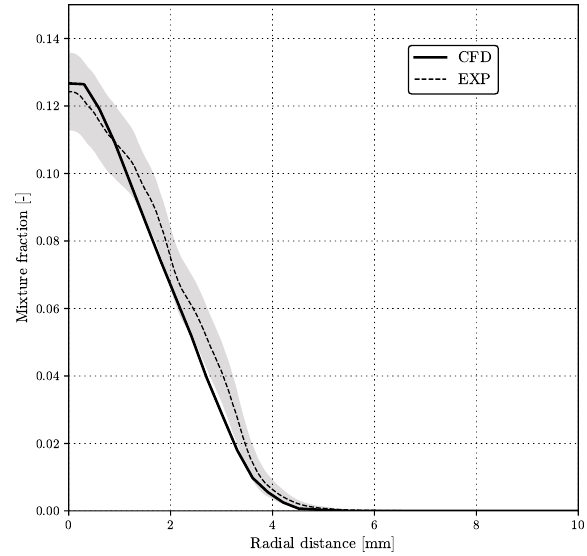
Figure 9. Radial mixture fraction distribution at z = 25 mm. Figure 10 gives the comparison at the location z = 45 mm. Again, the shape of the “Gaussian” mixture fraction profile is in good agreement with the measurements, but there was a slight underprediction over the entire sampling radius.